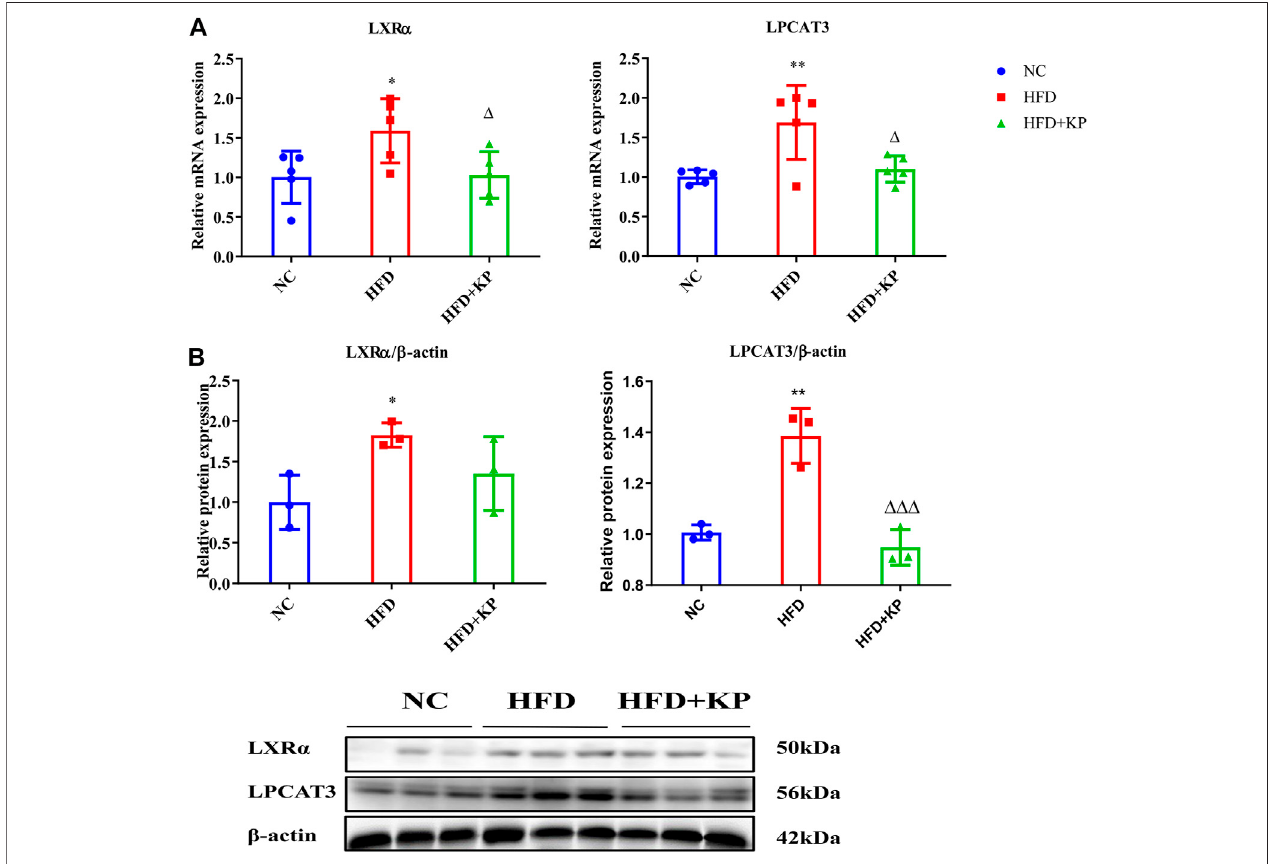
FIGURE 1 | KP regulated the mRNA and protein expression of LXR α and LPCAT3 in vivo . (A) : mRNA level expression of LXR α and LPCAT3 in liver samples; (B) : Protein level expression of LXR α and LPCAT3 in liver samples. NC: Normal control group, HFD: HFD group, HFD + KP: HFD + KP group. Quanti fi cation of mRNA and protein level expression was normalized to ß-actin levels. Compared with group NC, *, p < 0.05, **, p < 0.01; Compared with group HFD, △ , p < 0.05.